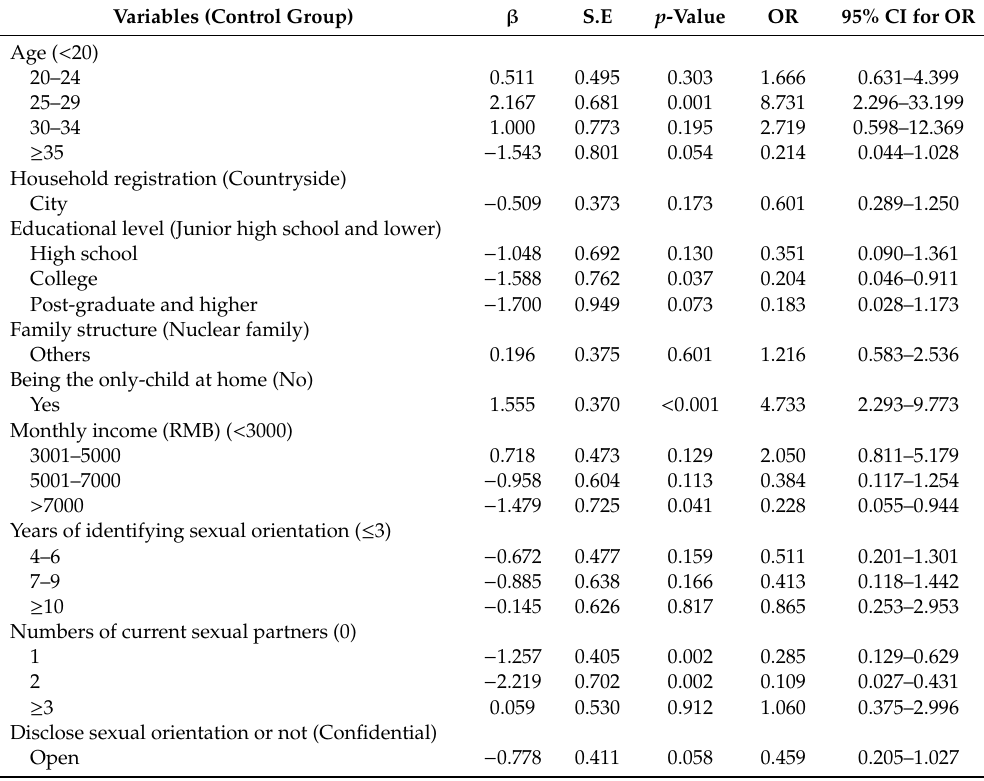
Table 2. Logistic regression analysis of influencing factors of interpersonal